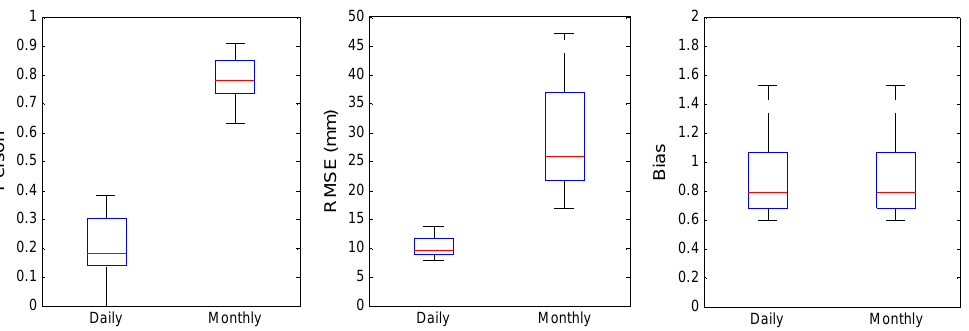
Figure 3. Obtained statistics (Pearson correlation coefficient, RMSE, and Bias) for daily and monthly time scale. Climate 2016 , 5 , 1